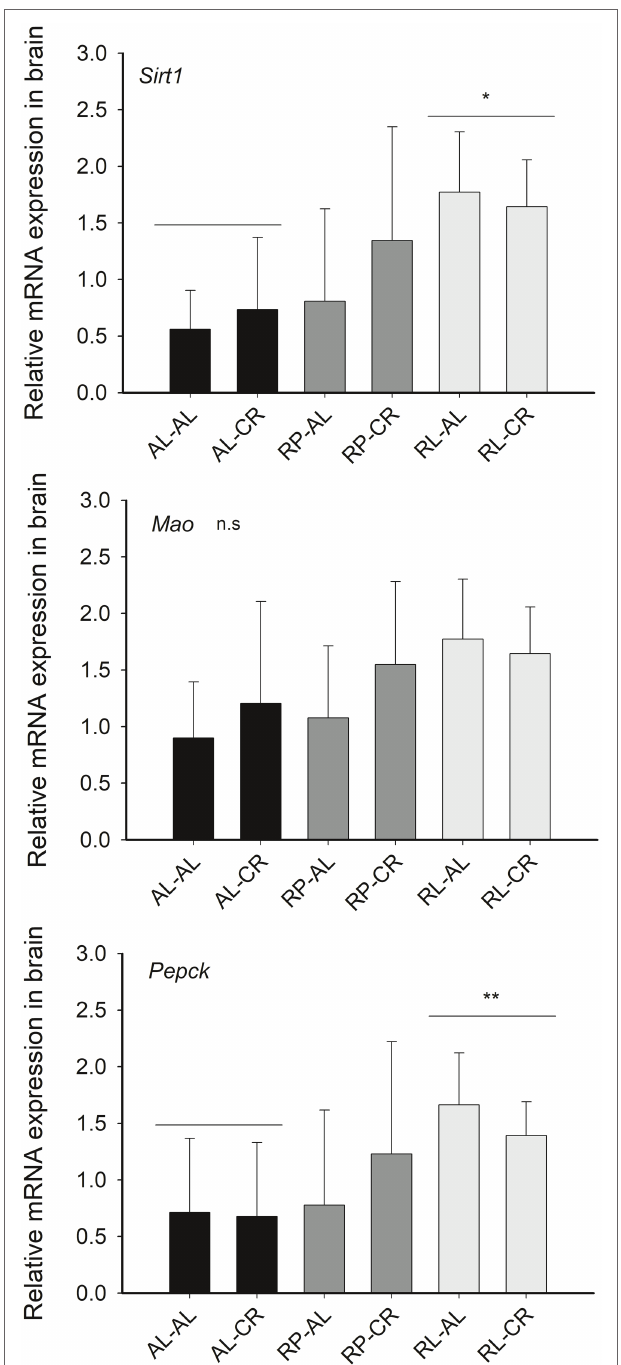
FIGURE 4 | Relative expression of genes related with Sirt1 (respect to B2m ) in the brains of mice from six groups of perinatal and adult food availability. See statistical results in main text for all graphs. One asterisk: p < 0.05; two asterisks: p =